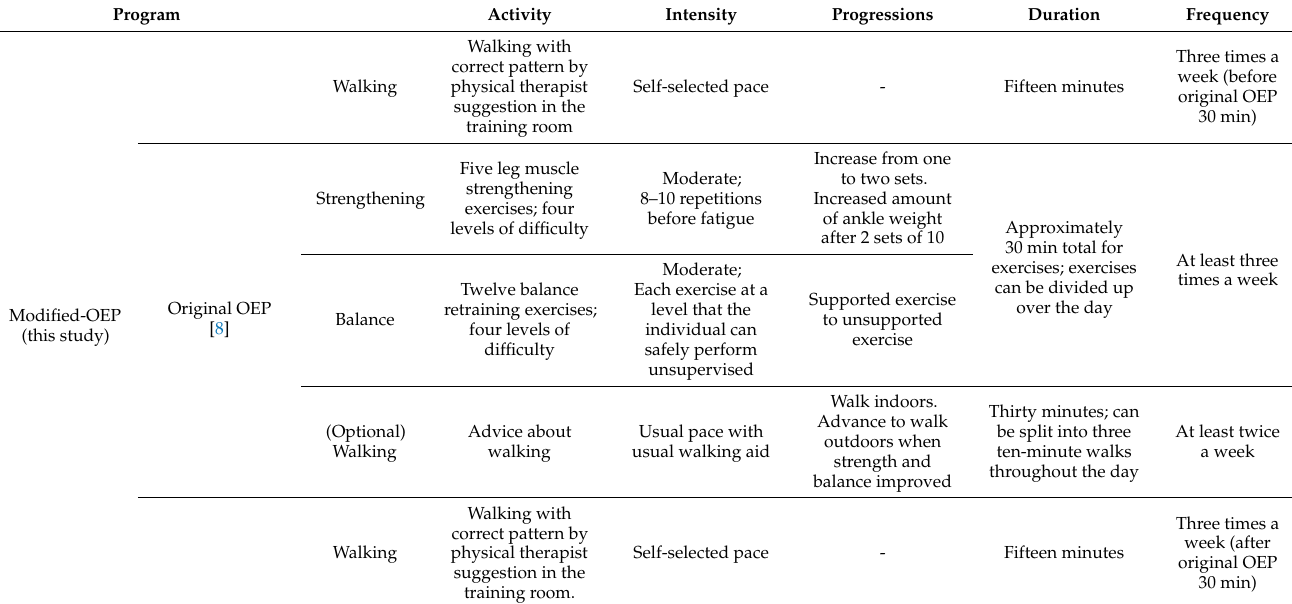
Table 2. Features of the